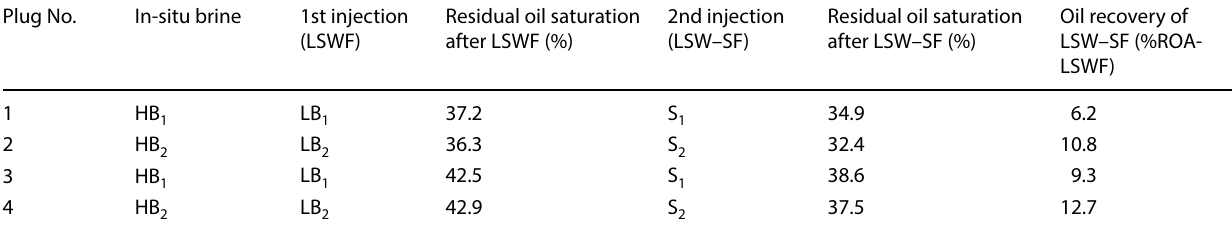
Table 9 Comparison of oil recoveries after sequential injection of LSWF and LSW–SF in core flooding tests Plug No. In-situ brine 1st injection